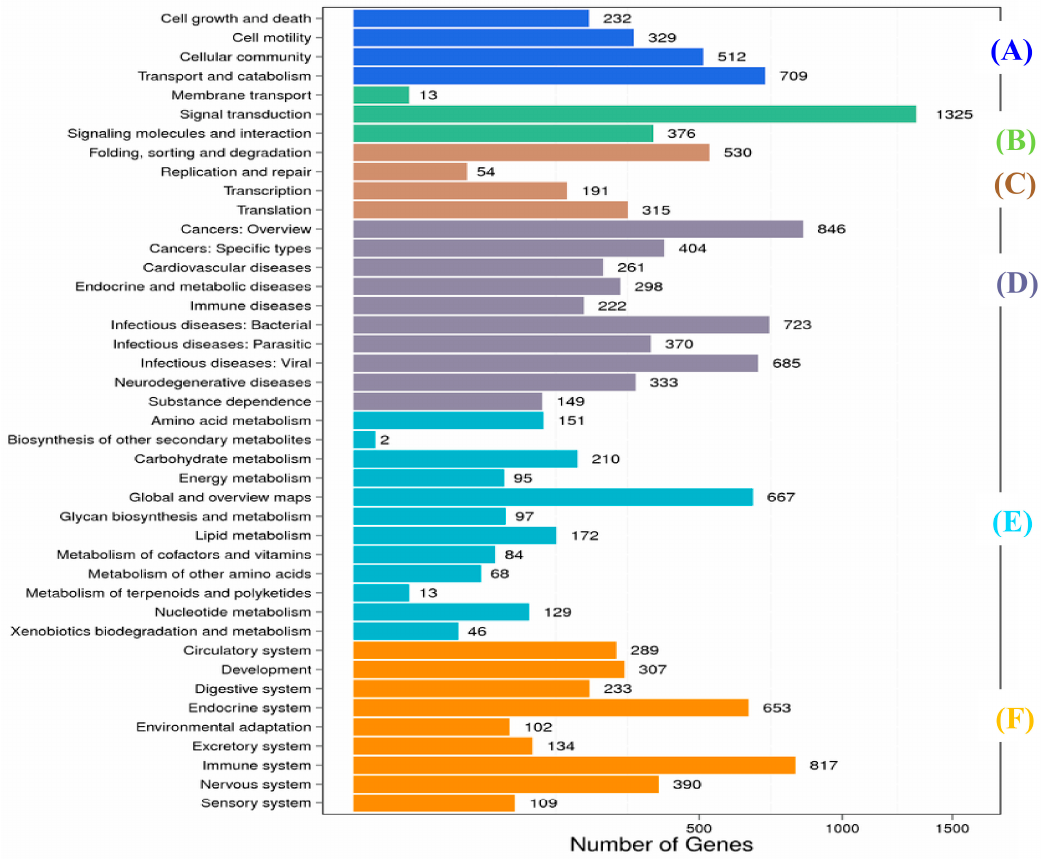
Figure 1. Up-regulation and down-regulation of differential expressed genes (DEGs) in muscle and spleen after challenge with Aeromonas sobria ( A. sobria ) in koi carp.